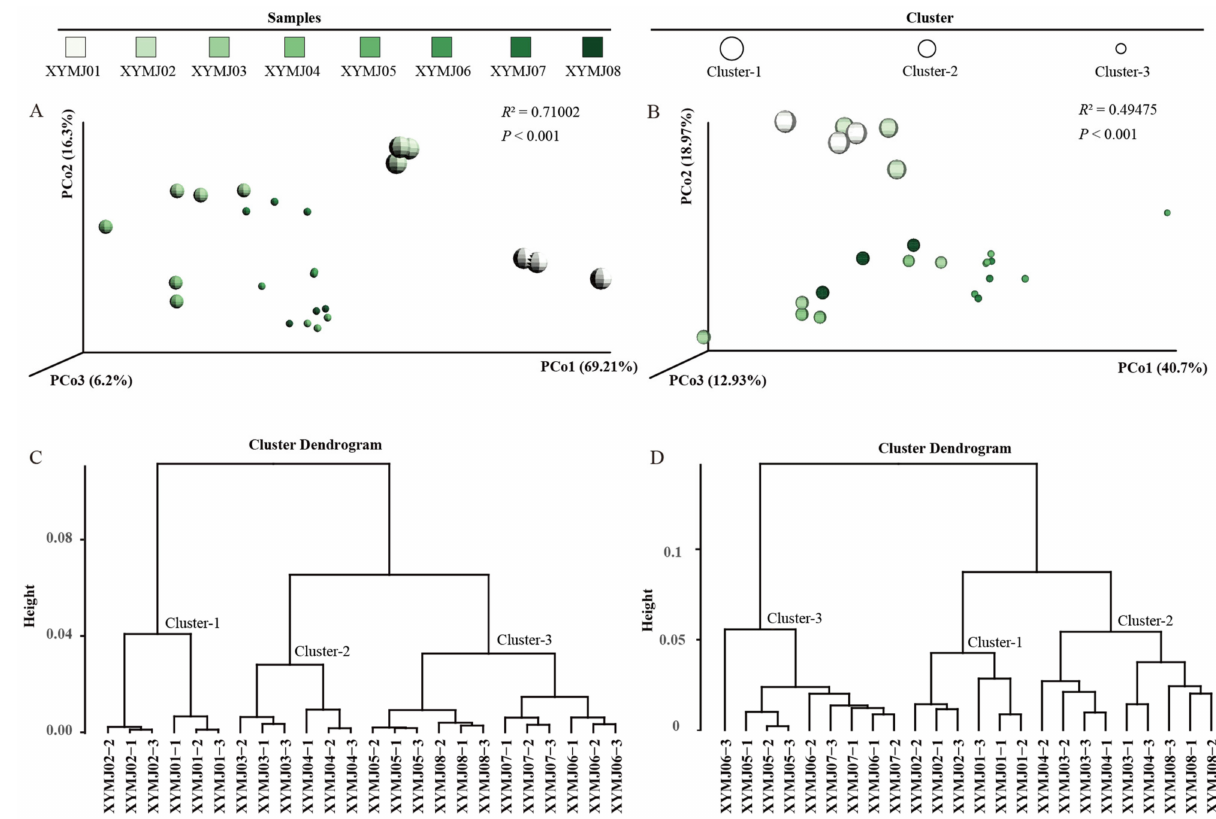
Figure 1. Principal coordinate analysis ( A , B ) and hierarchical clustering analysis ( C , D ) of XYMJ green teas. The β diversities of non-volatile compounds and volatile compounds were based on Manhattan dissimilarities. ( A , B ): PCoA scatter plots of the non-volatile compounds and volatile compounds in XYMJ green teas, ( C ) (non-volatile compounds) and ( D ) (volatile compounds): the dendrograms represent HCA. PERMANOVA R 2 and p values are indicated for the 3 clusters of the metabolic profile, which were represented by the circles of different